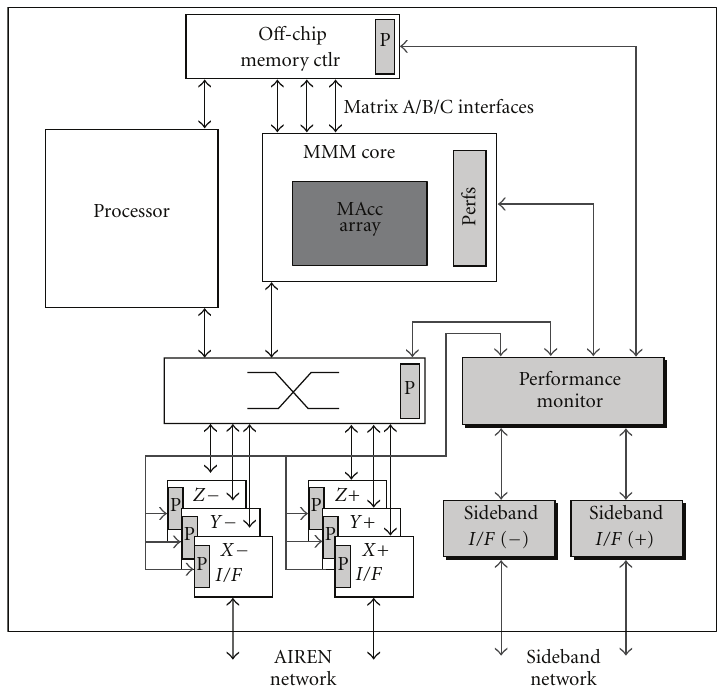
Figure 17: Block diagram of the performance monitor infrastructure used in the matrix-matrix multiplication evaluation.